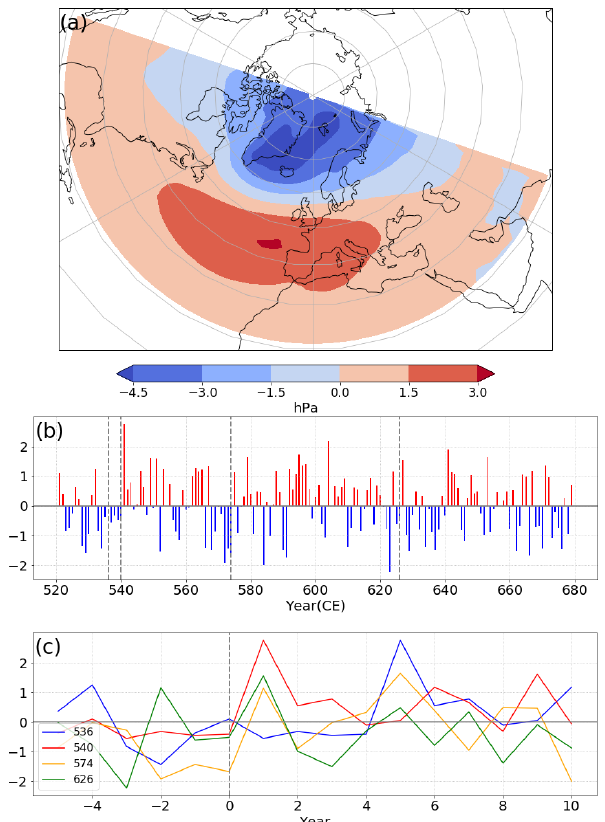
Figure A4. NAO DJF for (a) the climatological NAO signal for the 1–1850CE past2k run 0 and the response as (b) a time series of the ensemble mean NAO index as well as (c) an epoch analysis of the NAO index for the four large eruptions during 520 to 680CE. The eruption years are indicated with a dashed vertical black line in (b) . DJF year 0 corresponds to December of the year before the eruption and January to February of the year of the eruption.